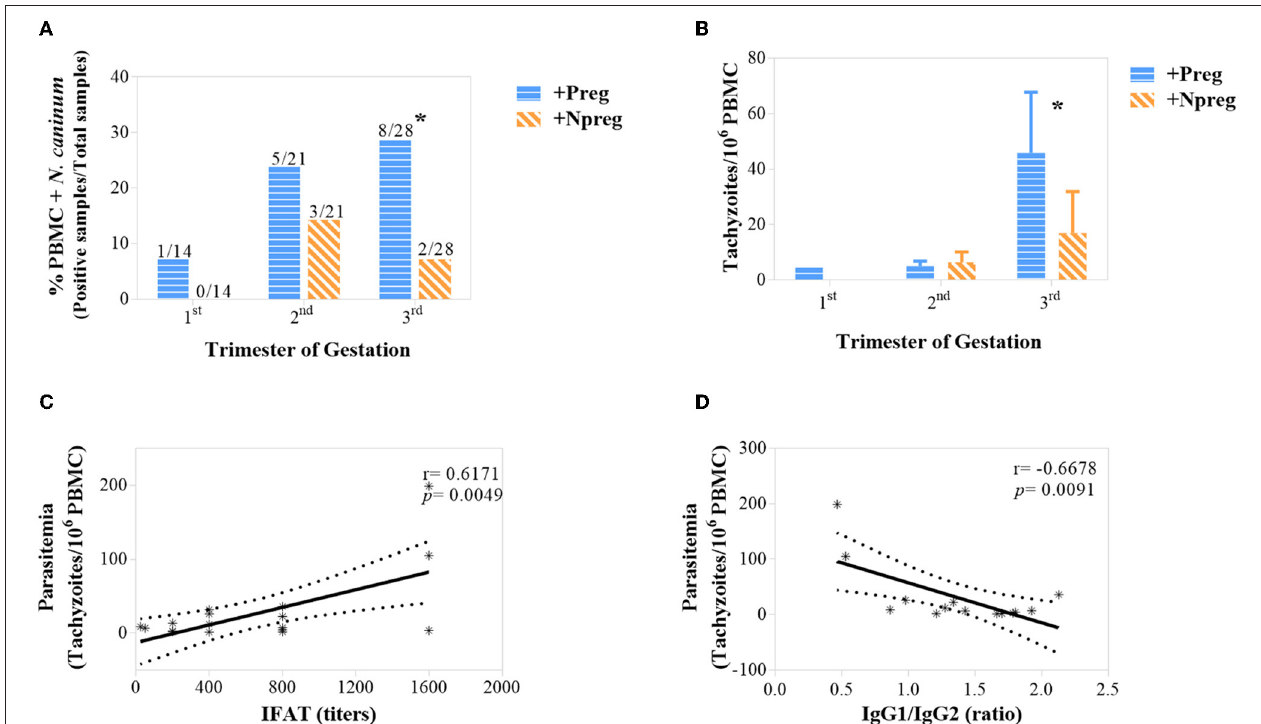
FIGURE 5 | Percentage of Neospora caninum DNA detected in PBMC using conventional PCR along gestation. Bars represent the total of positive samples/total samples analyzed and y -axis represents % of positive samples (A) . Neospora caninum concentration (tachyzoites/10 6 PBMC) along gestation. Bars represent the mean ± standard error of the mean (SEM) (B) . Correlations between parasitemia and IFAT (C) and IgG1/IgG2 ratio (D) . The significant statistical differences between groups were analyzed: * p < 0.05.